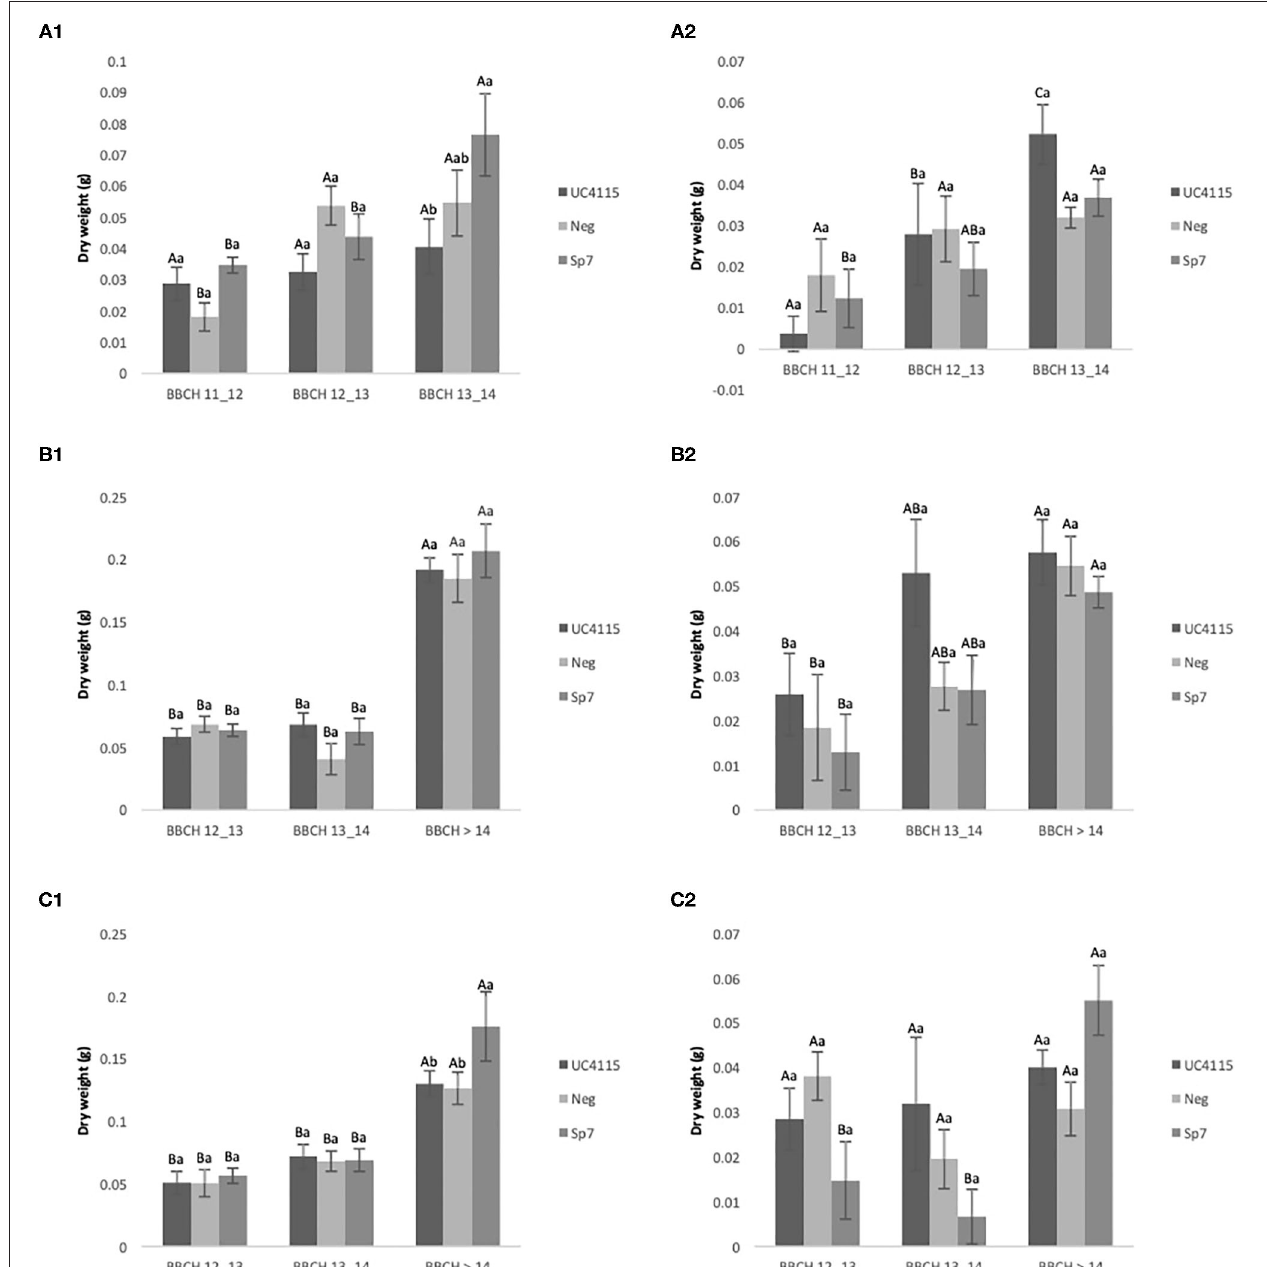
FIGURE 2 | Conventional experiment. Evolution over time of tomato plant above-ground biomass (A1,B1,C1) and below-ground biomass (A2,B2,C2) after inoculation with UC4115, Sp7, and negative control at seed level (A1,A2) , root level (B1,B2) , and seed plus root level (C1,C2) . Mean values ± standard deviation. Capital letters indicated differences among physiological state (BBCH) of tomato plant within the same inoculation; lowercase letters indicate differences among different inoculations within the same physiological state.